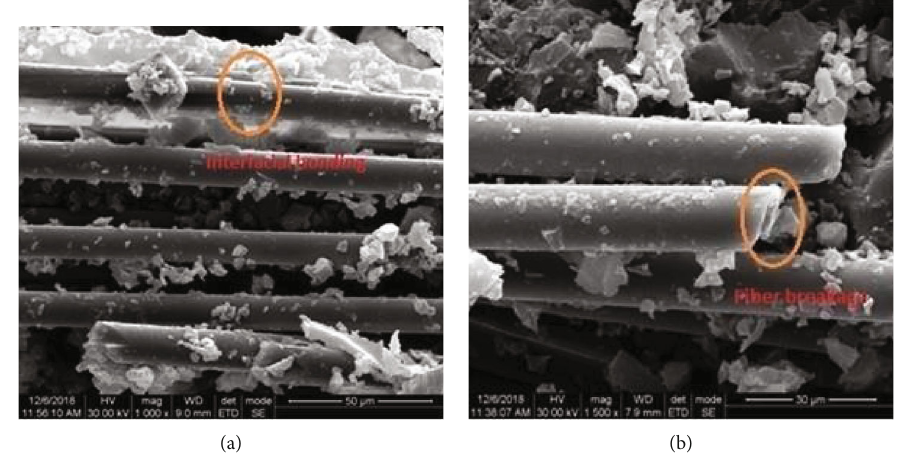
Figure 3: Tensile fracture surface micrograph. (a) 1.5wt.%. (b) 2wt.%. Table 1: Tensile property of nanoparticle reinforced epoxy composites.